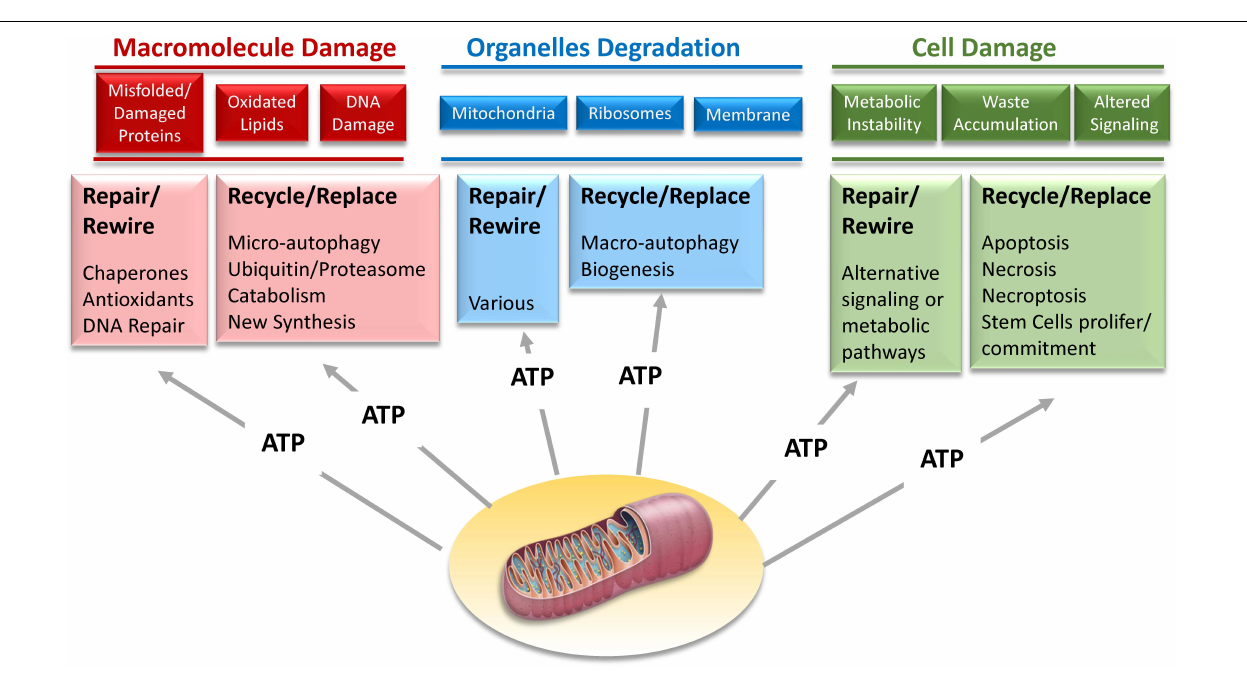
FIGURE 10 | Mechanisms of resilience that maintain homeostatic stability on the dynamic network of life aim to repair damage at macromolecular, organelle, and cellular level. However, when the repair is not possible, recycling and replacing these macromolecules, organelles and cells is a suitable alternative. Most of these strategies of biological resilience requires large amounts of energy that can only be provided through mitochondria oxidative phosphorylation.